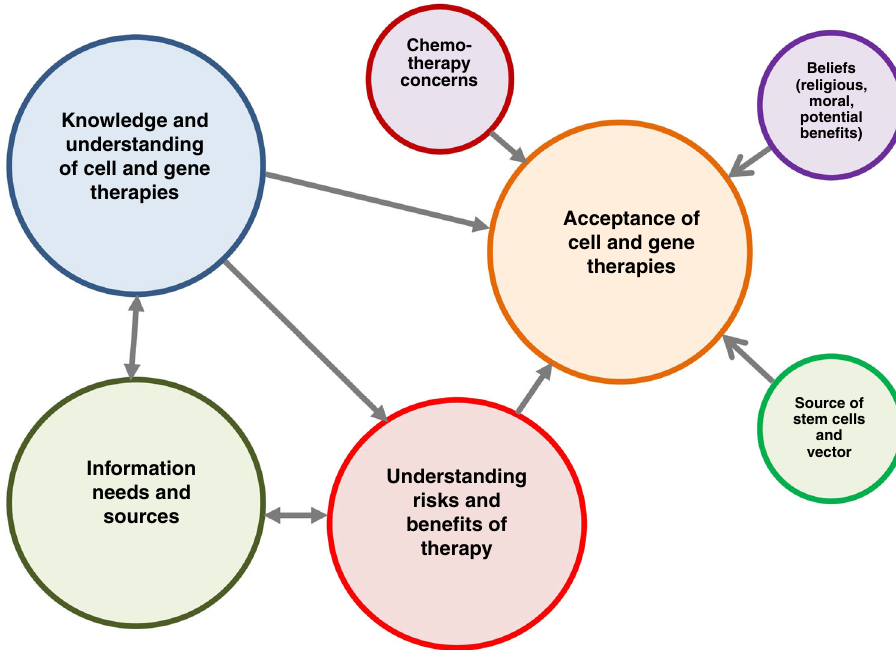
Fig. 1 Hypothetical model of thematic relationships based on review fi ndings. Arrows indicate hypothetical unidirectional relationships. Double arrows indicate hypothetical bidirectional